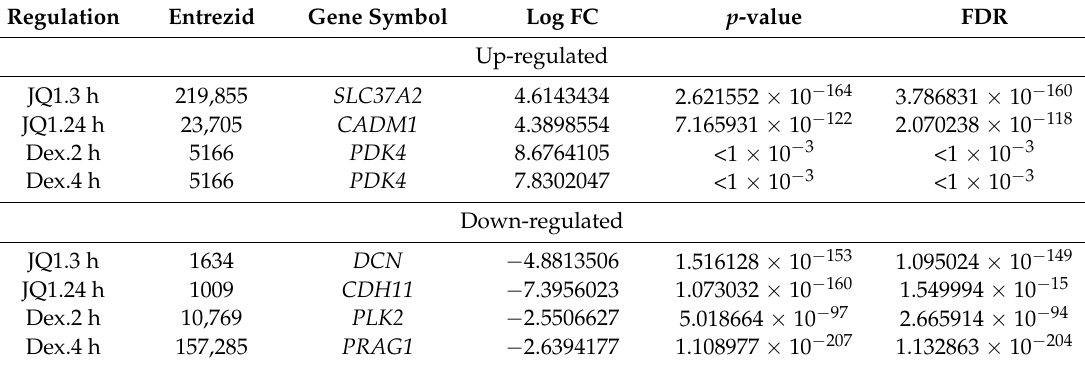
Table 2. Top most significantly up-& downregulated differentially expressed